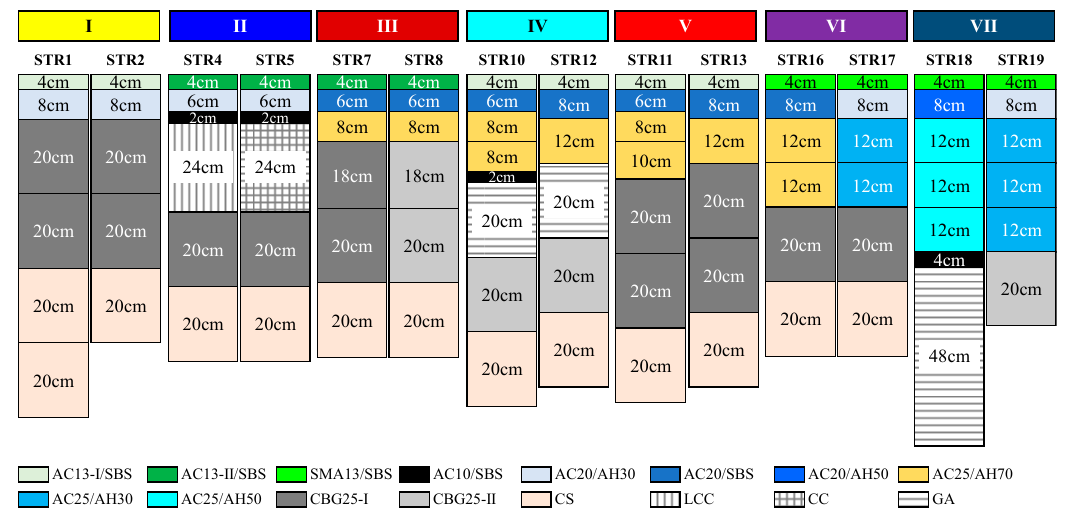
Figure 2. The RIOHTrack structure.